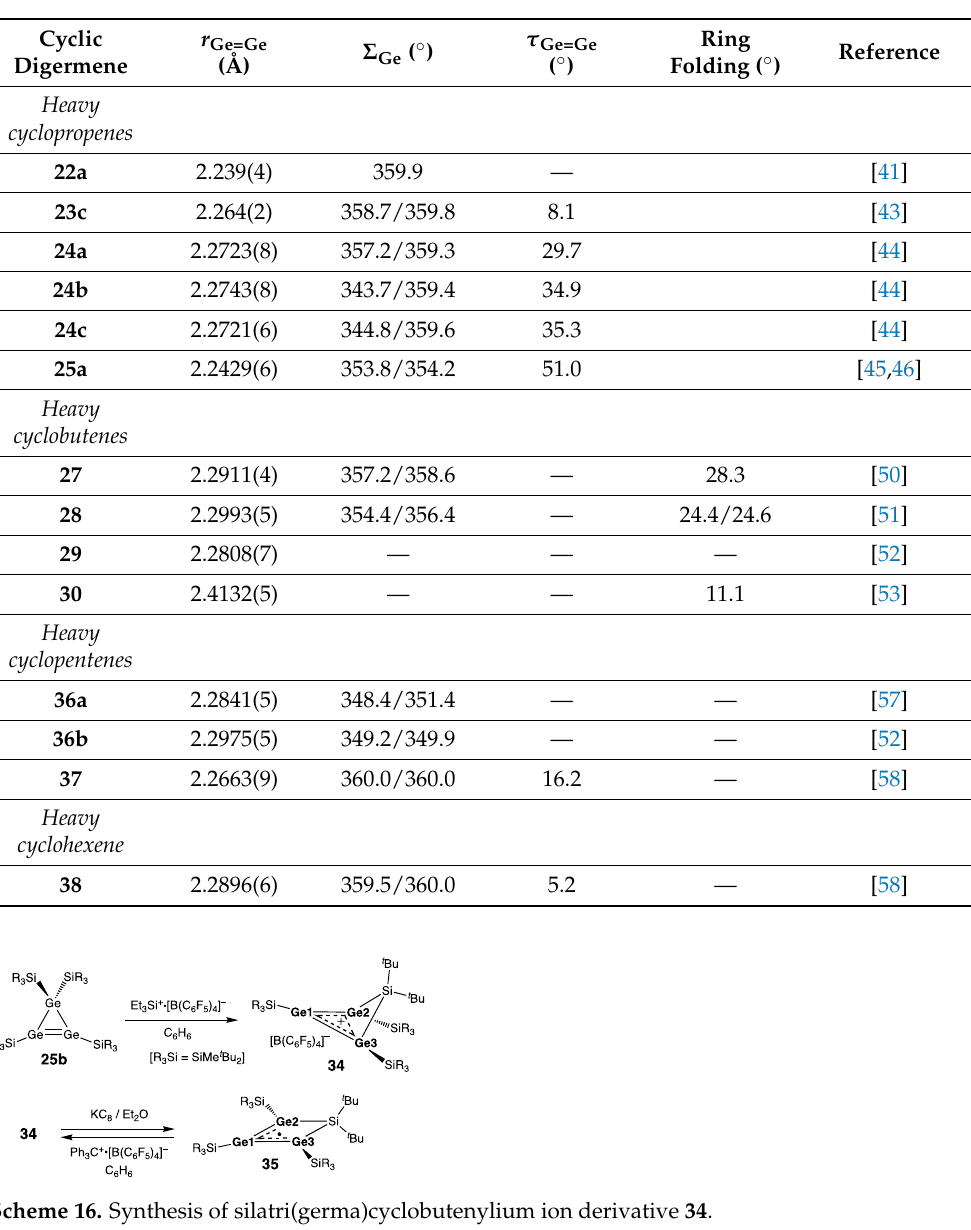
Table 2. X-ray crystallographic parameters of the stable cyclic digermenes. The “ — ” implies lack of the relevant structural information. Cyclic Digermene